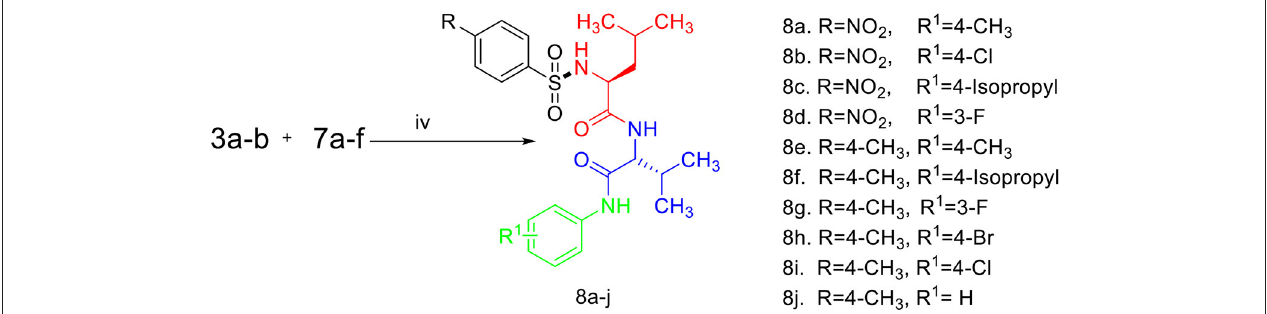
TABLE 2 | Binding free energy, 1 G (kcal/mol). Antibacterial Antimalarial Compound code 5MMN: 1 G (kcal/mol) Scoring function: London dG